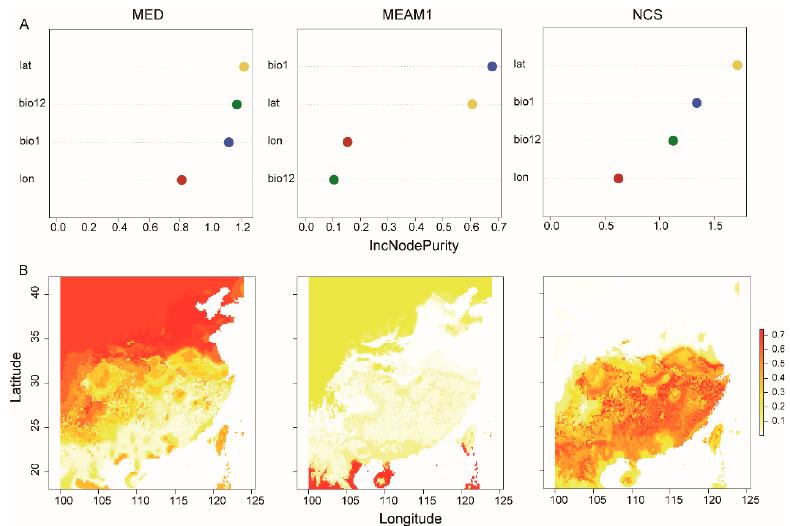
Figure 3. The suitable habitat distribution of Bemisia tabaci cryptic species in China. ( A ): the random forest model of different factors on the percentage of Bemisia tabaci cryptic species. Lat, latitude; Bio1, annual mean temperature; Bio12, annual precipitation; lon, longitude. The different colors represent the different environmental factors. ( B ): The suitable habitat distribution of Bemisia tabaci cryptic species.